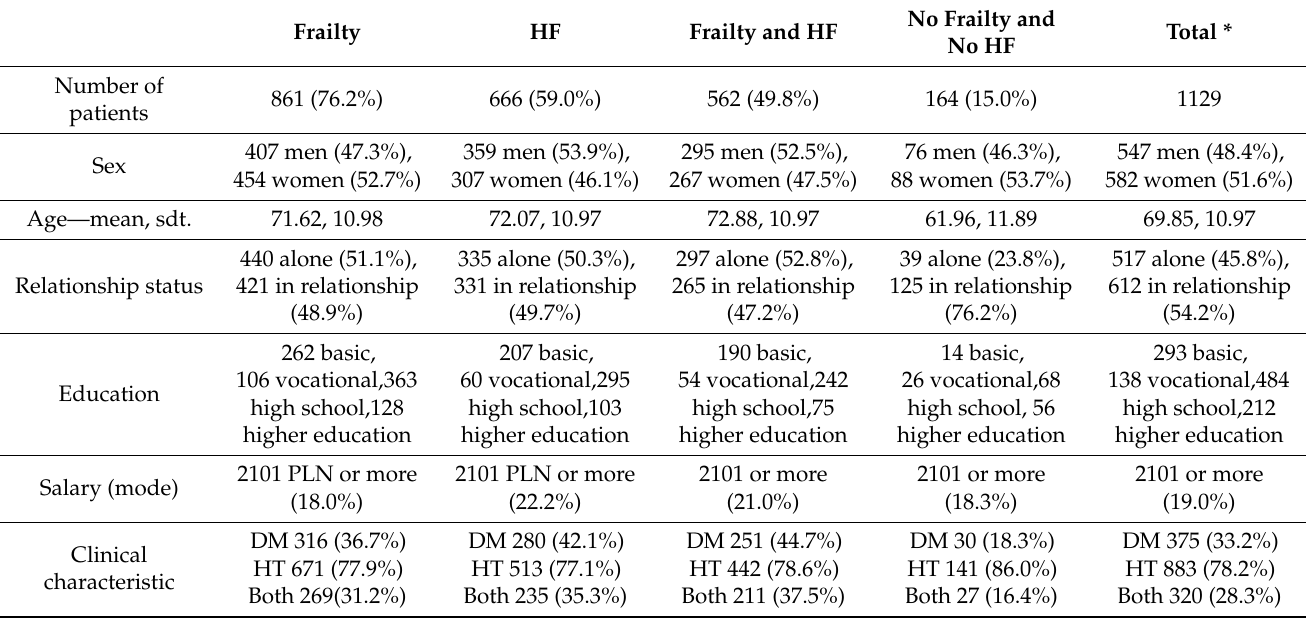
Table 1. Demographics and clinic data of the sample population.